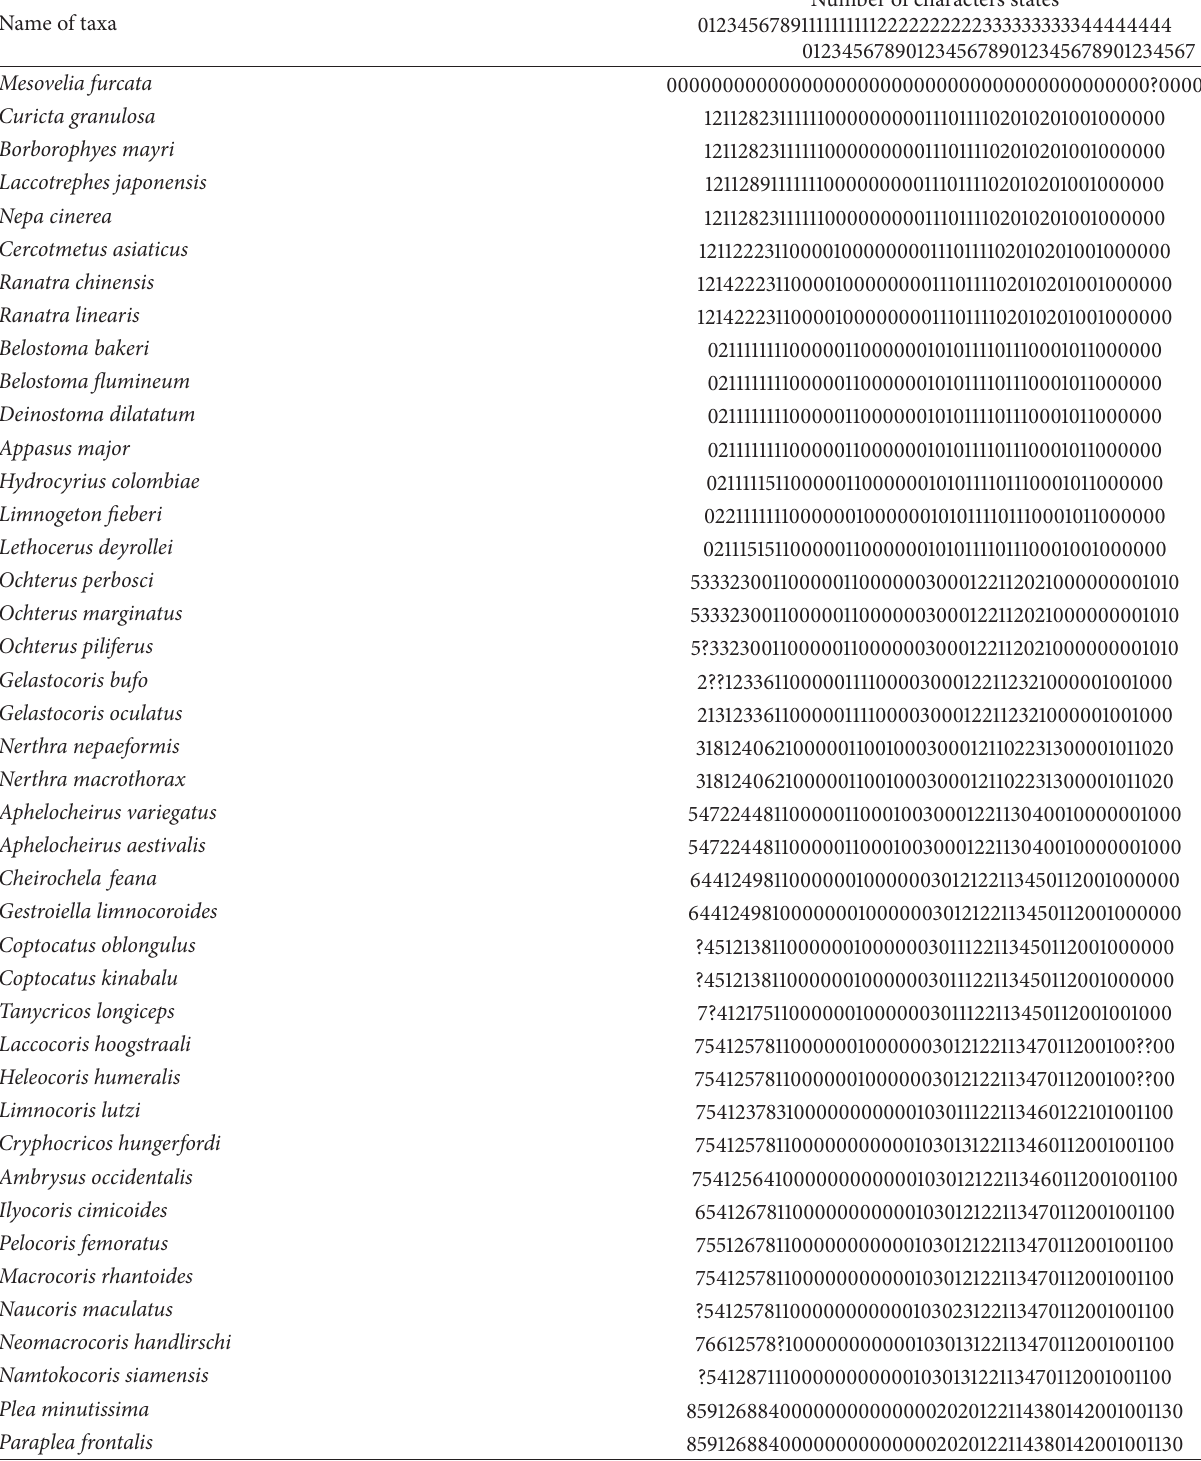
Table 3: The matrix of character states in nepomorphan species and outgroup (Gerromorpha: Mesovelia furcata )